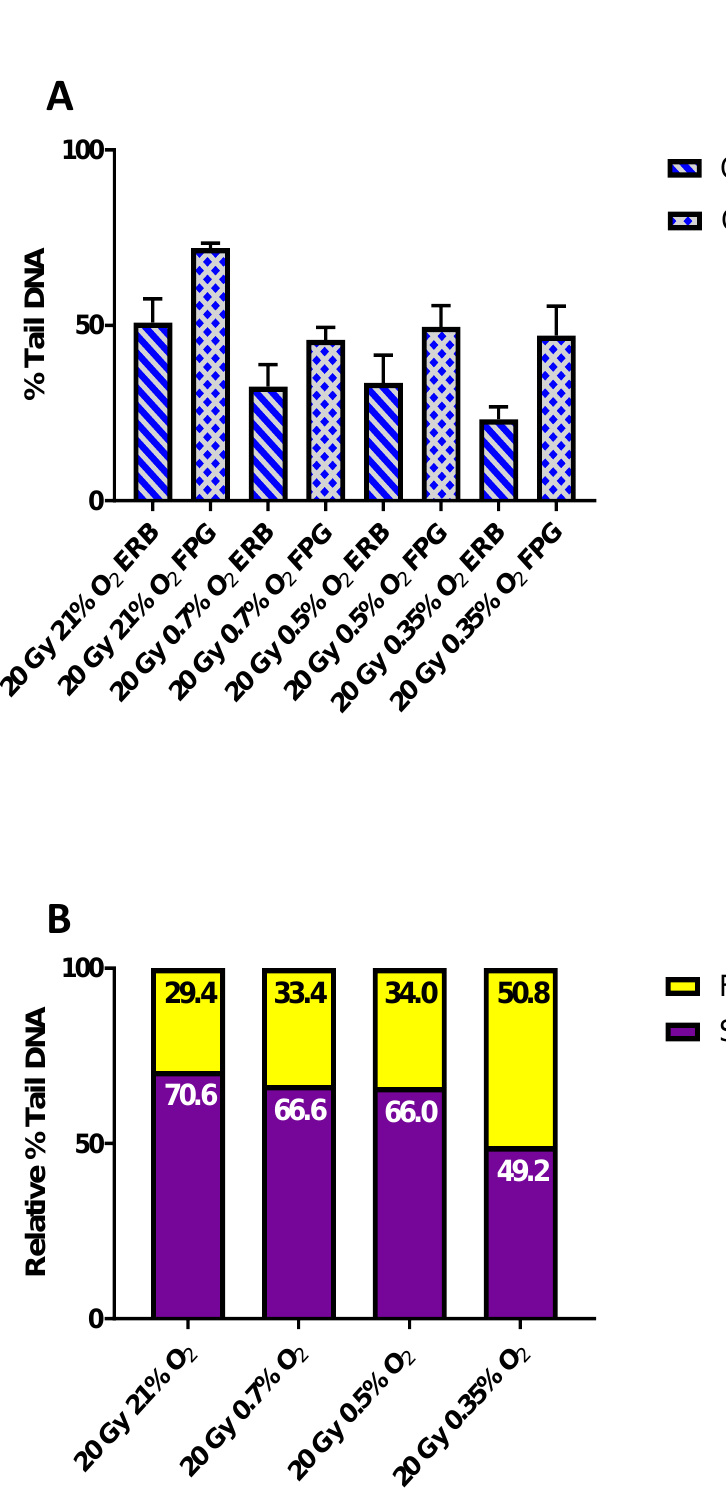
Figure 2. ( A ) Alkaline Comet assay measures of DNA damage formation (% Tail DNA) in whole- blood peripheral blood lymphocytes (WB-PBL) following 20 Gy CONV irradiation at 21, 0.7, 0.5, or 0.35% O 2 and treatment of the post-lysis-generated nucleoids with either FPG (0.1 U per gel) (columns 2, 4, 6, and 8) or ERB-only (columns 1, 3, 5, and 7). Data are expressed as the mean % Tail DNA of three slides ( n = 3). Error bars indicate standard deviation of the means for each experimental condition. ( B ) The determined relative levels of induced strand break damage (SSB) vs. FPGss following 20 Gy CONV irradiation at 21, 0.7, 0.5, or 0.35% O 2